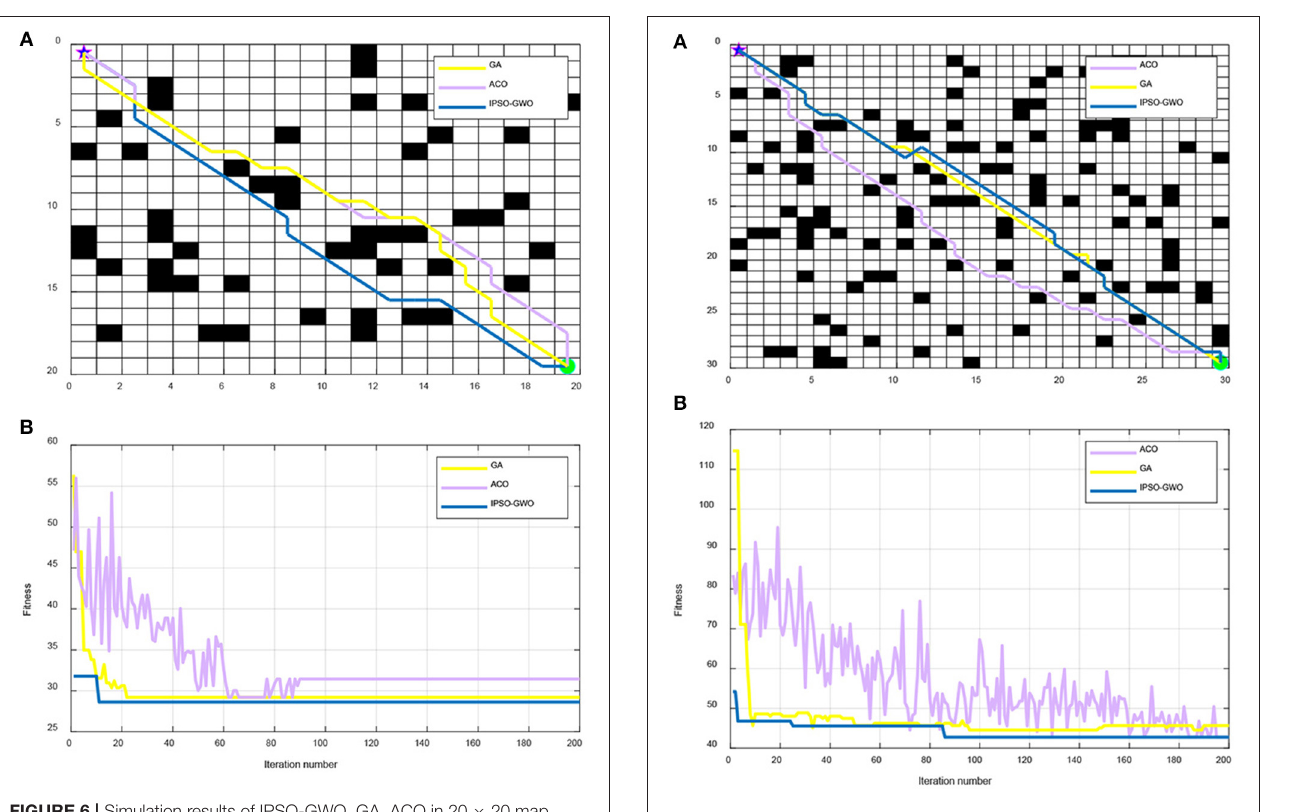
FIGURE 7 | Simulation results of IPSO-GWO, GA, and ACO in 30 × 30 map environment. (A) Path comparison with ACO, GA, and IPSO-GWO algorithms. (B) Iterative curves with ACO, GA, and IPSO-GWO